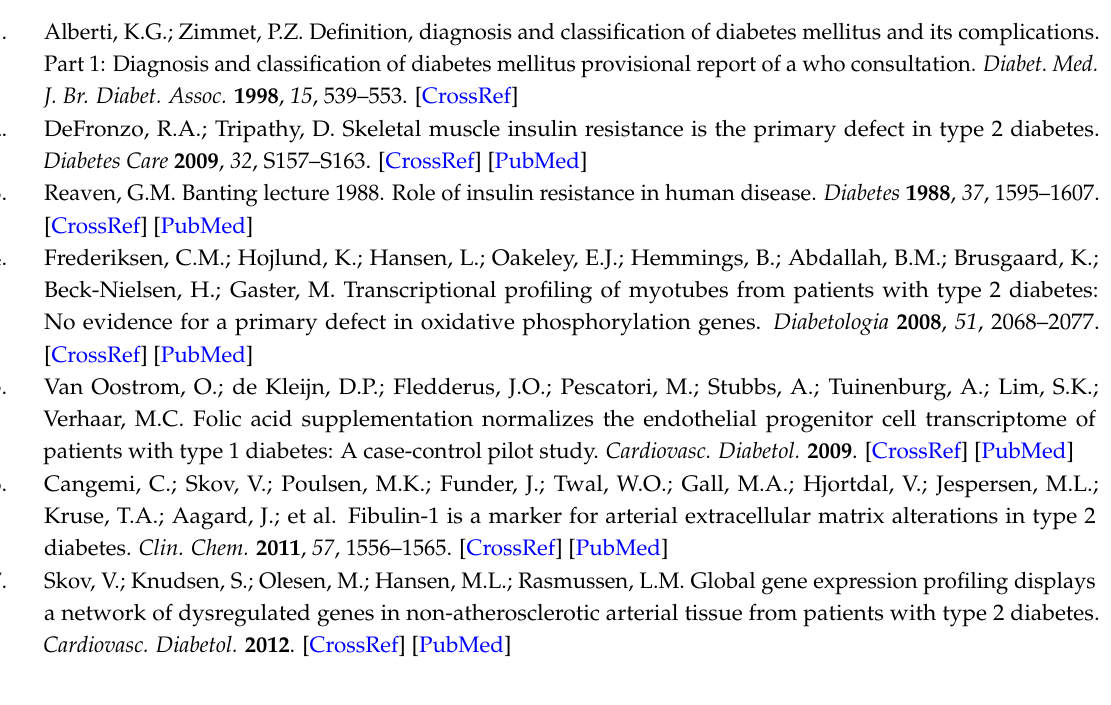
Figure S1: Forest plot of UV response (DACOSTA_UV_RESPONSE_VIA_ERCC3_DN); Figure S2: Forest plot of chronic myelogenous leukemia (DIAZ_CHRONIC_MEYLOGENOUS_LEUKEMIA_UP). Figure S3: Forest plot of KLF1 targets (PILON_KLF1_TARGETS_DN); Figure S4: Forest plot of SMARCA2 targets (SHEN_ SMARCA2_TARGETS_UP); Figure S5: Forest plot of Alzheimer’s disease (BLALOCK_ALZHEIMERS_DISEASE_ DN); Figure S6: Forest plot of stromal stem cells (BOQUEST_STEM_CELL_CULTURED_VS_FRESH_UP); Table S1: Description of differentially expressed genes; Table S2: Description of significantly identified gene sets; Table S3: Gene set enrichment analysis of UV response; Table S4: Gene set enrichment analysis of chronic myelogenous leukemia; Table S5: Gene set enrichment analysis of KLF1 targets; Table S6: Gene set enrichment analysis of SMARCA2 targets; Table S7: Gene set enrichment analysis of Alzheimer’s disease; Table S8: Gene set enrichment analysis of stromal stem cells; Table S9: Significant correlation of gene expression association; Table S10: Significant independence of gene expression association; Table S11: Significant correlation of pathway expression association. All expression datasets are available at the https://www.ncbi.nlm.nih.gov/geo/ and can be accessed by the GDS